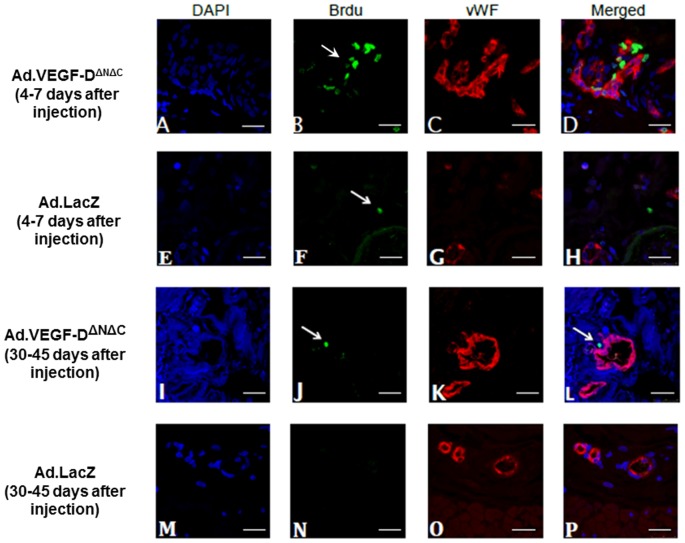
Proliferation and Neovascularization in Ad.VEGF-DΔNΔC–transduced uterine arteries.Clusters of proliferating endothelial cells in the short and long term sheep injected with Ad.VEGF-DΔNΔC (A–D and I-L respectively) and with Ad.LacZ (E–H and M–P respectively). Pictures A,E,I,M, show the staining of the nuclei with DAPI. The arrows in pictures B,F,J show nuclei which are positive to BrdU. The column containing C,G,K,O pictures shows positive staining to vWF. The merged pictures D,H,L,P, show the positive association of the BrdU stained nuclei with vWF which confirms that these nuclei belong to proliferating endothelial cells. Scale bar = 50 µm.